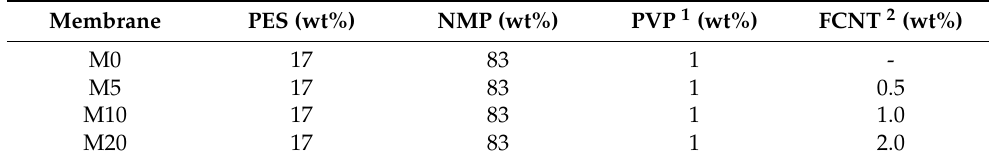
Table 1. Composition of dope solutions for FCNT/PES nanocomposite HF membranes.